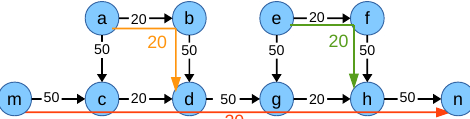
Figure 9. Example scenario for NFF with optimum allocation. Blue circles: nodes; black arrows/ numbers: links with capacities; colored arrows/numbers: flows with capacity assignments. All values in Mbps.